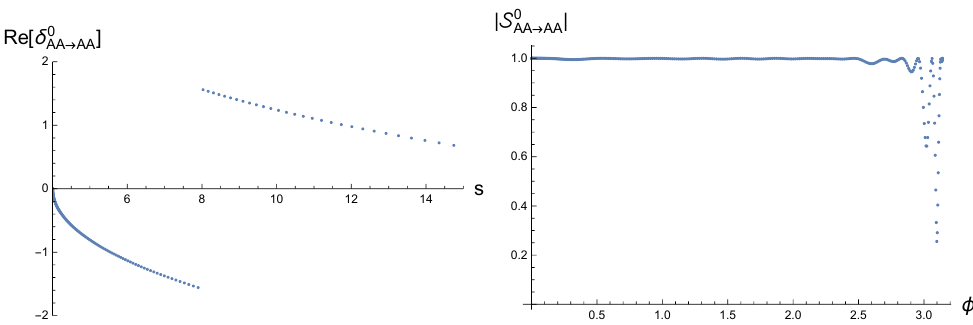
Figure 6 . Real and imaginary parts of the spin 0 interacting part of the AA → AA partial amplitude leading to the absolute minimum of the a -anomaly. It is constructed at N max = 20 and L max = 30 .